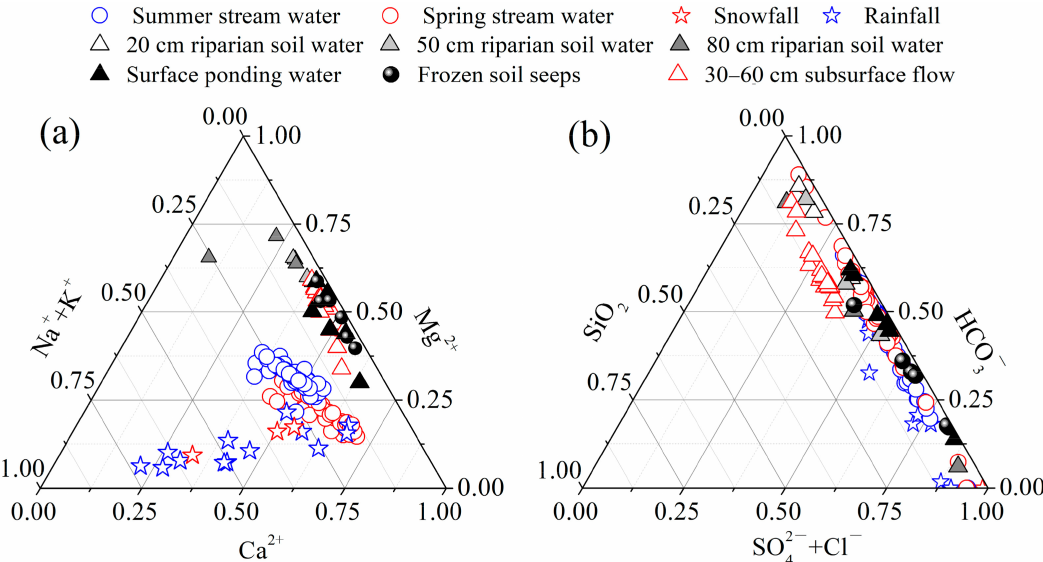
Figure 3. Piper diagram of major ions of different water